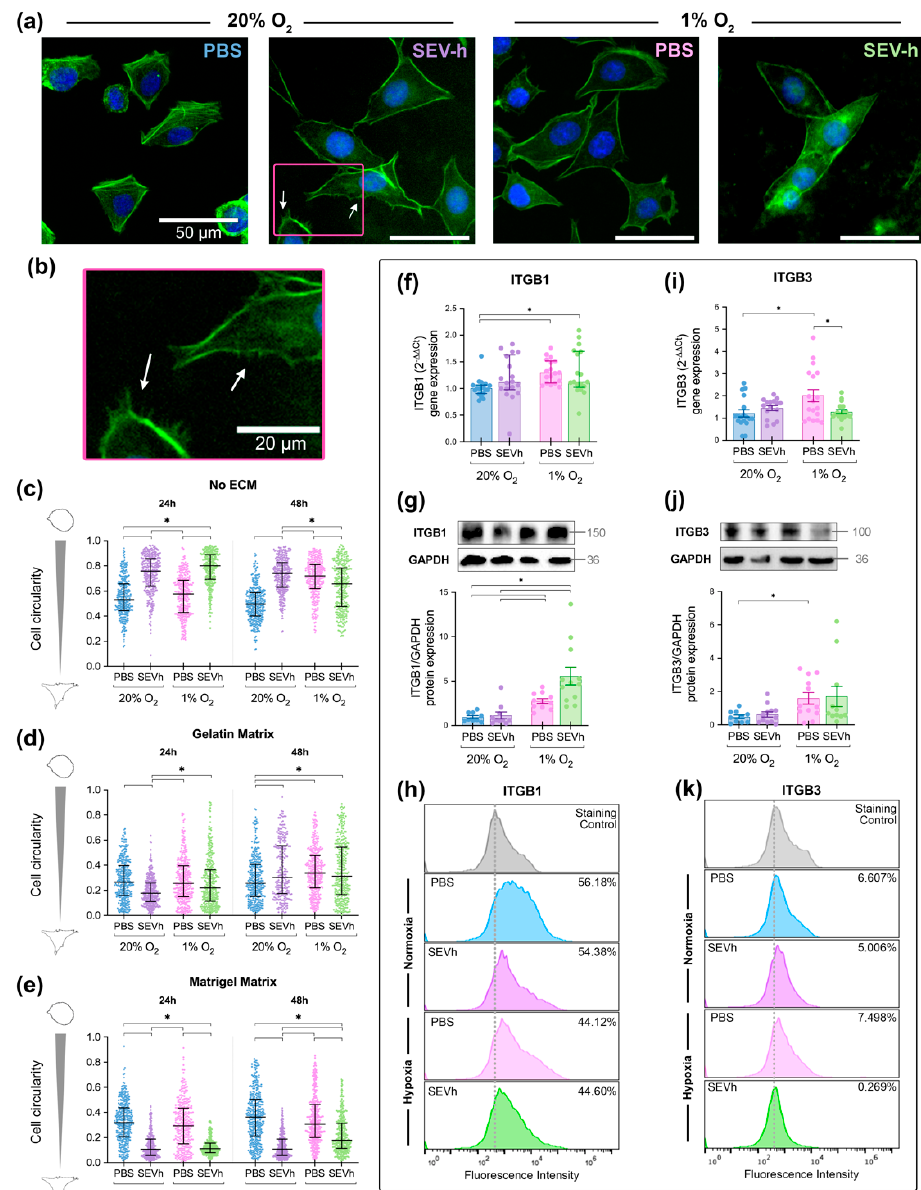
Figure 4. Phenotypical alterations promoted by hypoxia and/or SEVh exposure. ( a ) Representative images of untreated (PBS) and treated (SEVh) MDA-MB-231 cells in Matrigel matrix following a 24 h incubation in normoxia (20% O 2 ) or hypoxia (1% O 2 ). White arrows indicate the presence of invadopodia, indicating a migratory phenotype (scalebar: 50 µm). ( b ) Detailed vision of invadopodia in normoxic cells following SEVh exposure (scalebar: 20 µm). ( c – e ) Circularity determination after 24 h and 48 h of cells plated atop ( c ) an uncoated surface, ( d ) gelatin (0.2 mg/mL) matrix, and ( e ) Matrigel matrix (1:1, v / v ). ( f ) Gene expression (median ± interquartile), ( g ) whole cell protein expression (mean ± SEM), and ( h ) surface protein expression of integrin subunit β 1 (data presented as mean % of triplicates of two independent assays). ( i ) Gene expression (mean ± SEM), ( j ) whole cell protein expression (mean ± SEM), and ( k ) surface protein expression of integrin subunit β 3 (data presented as mean % of triplicates of two independent assays). * p <